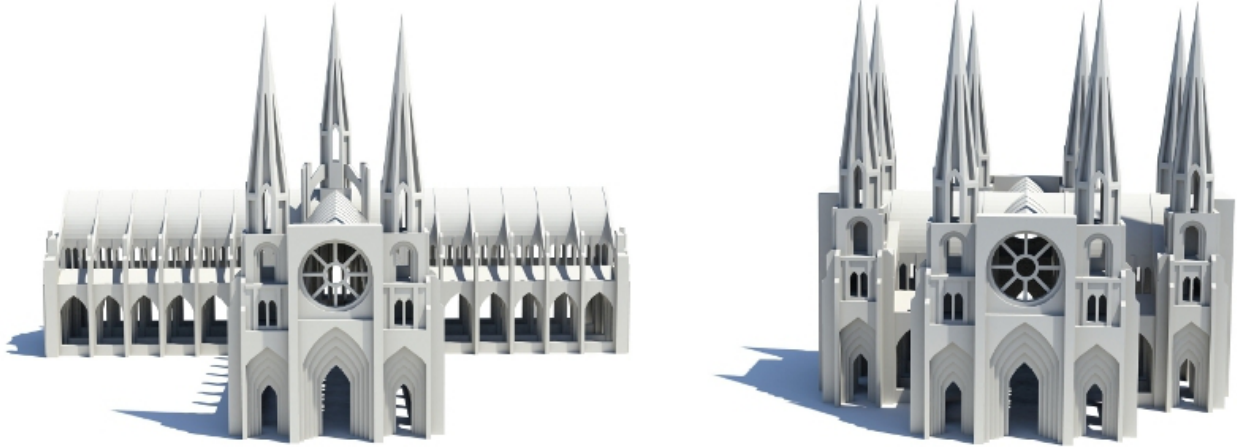
Figure 5. Gothic architecture is defined by strict rules with its characteristics.